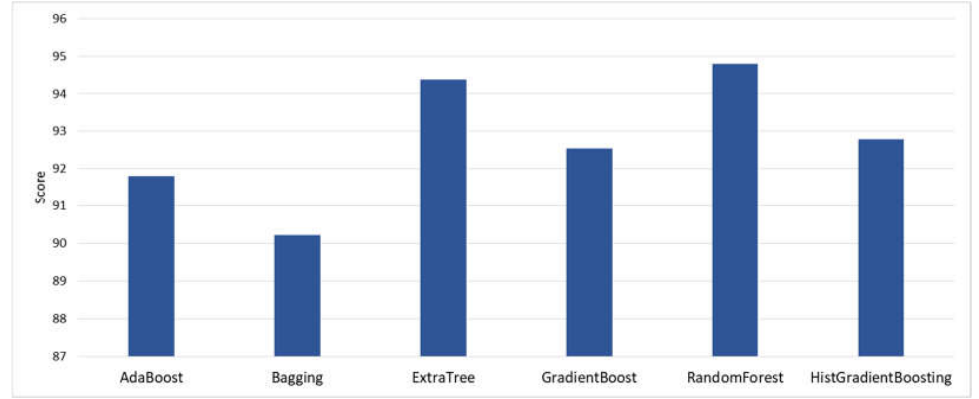
Figure 3. Comparison of algorithms for determining the initialization functions.